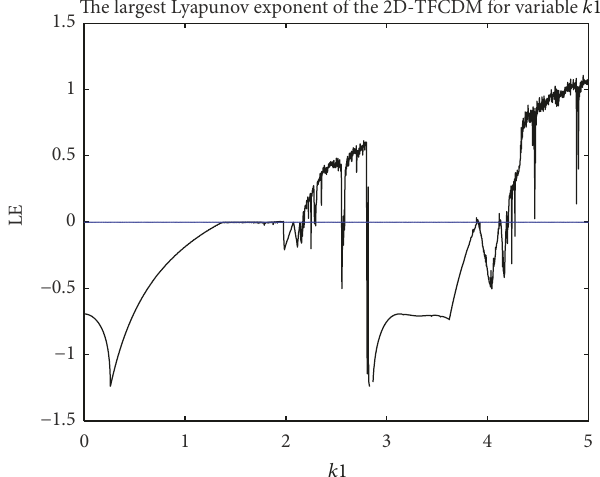
Figure 3: The largest Lyapunov exponent of the 2D-TFCDM of the variable 𝑘 1 .